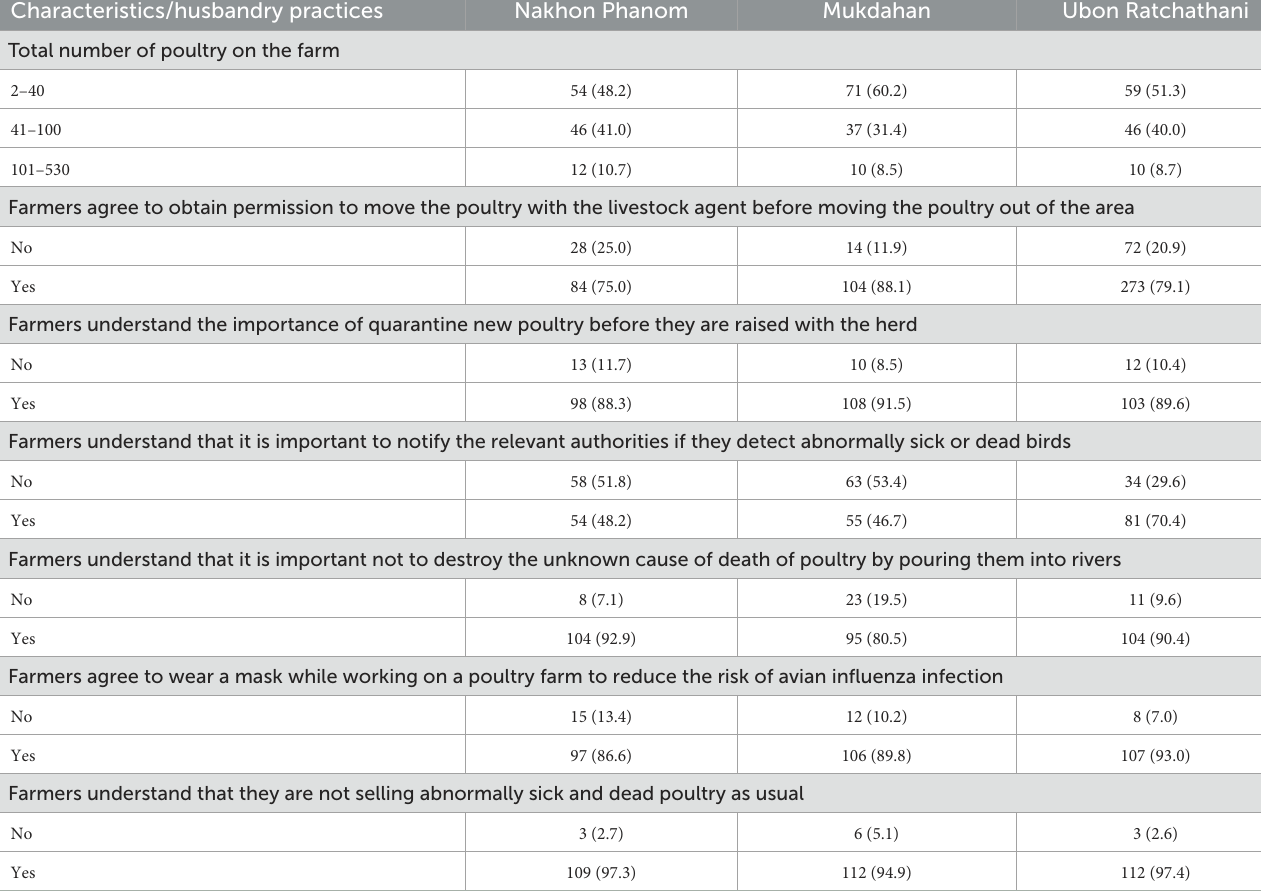
TABLE 1 Husbandry practices of poultry farmers along border areas in three provinces of